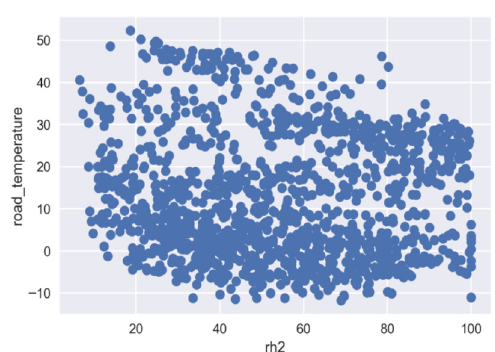
Figure 3. Scatter plot of humidity (rh2) and